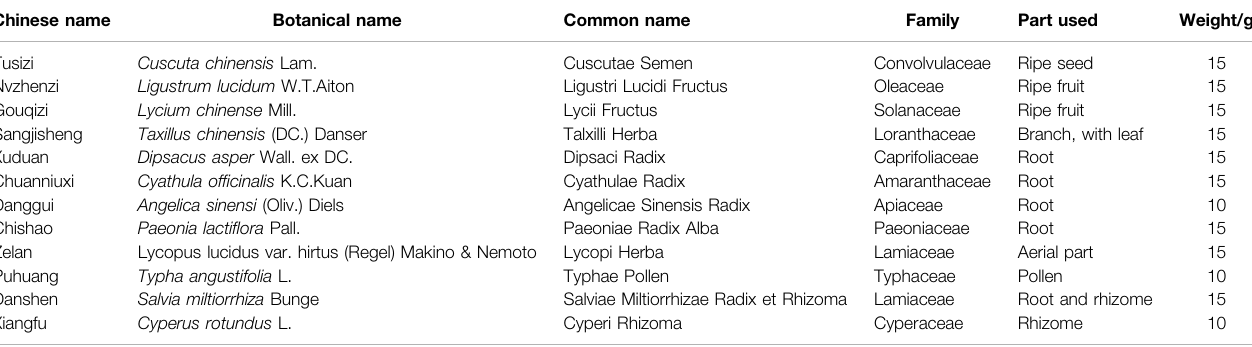
TABLE 1 | Information of components in Bushen Culuan